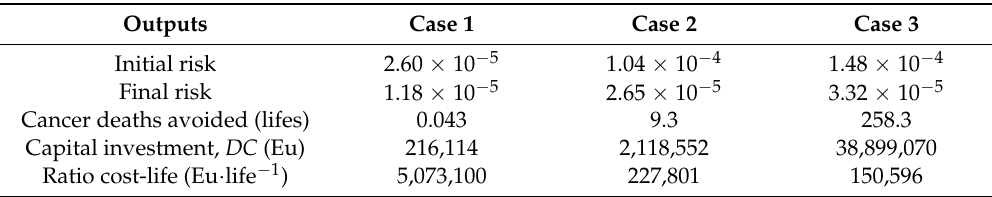
Table 6. Risk, capital investment, and cost to saved lives